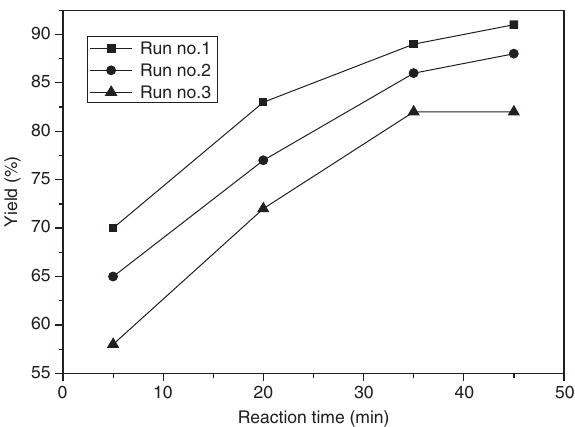
Figure 1 Recyclability of the catalyst in the reaction of benzaldehyde, cyclohexanone and aniline catalyzed by PPA/SiO